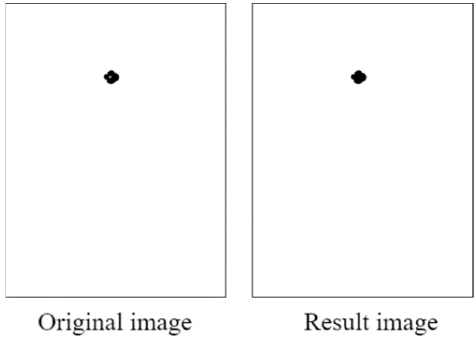
Figure 28. Image obtained after the open operation.